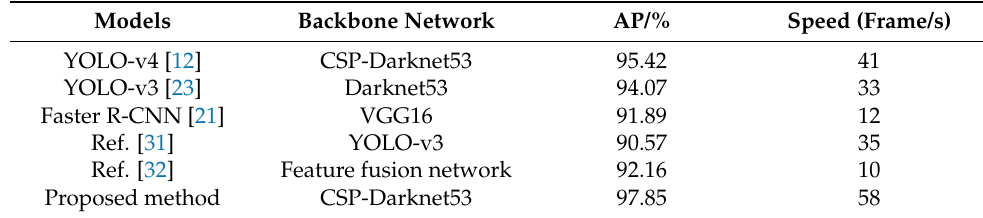
Table 4. Comparison results on the student behavior dataset.